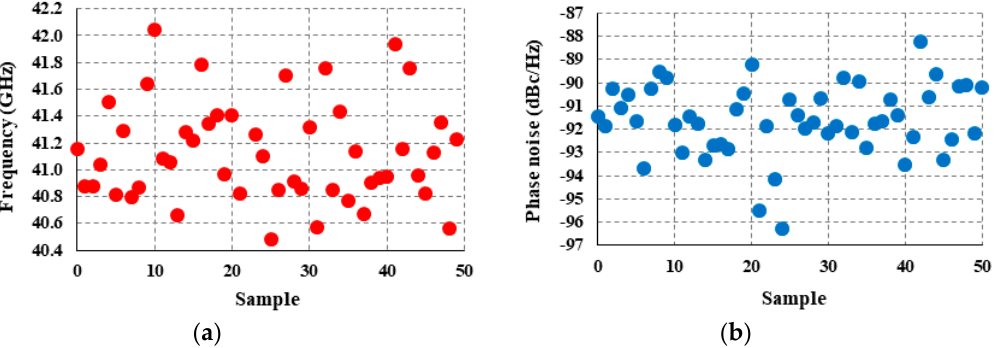
Figure 12. The Monte Carlo of the ( a ) oscillation frequency; ( b ) phase noise.